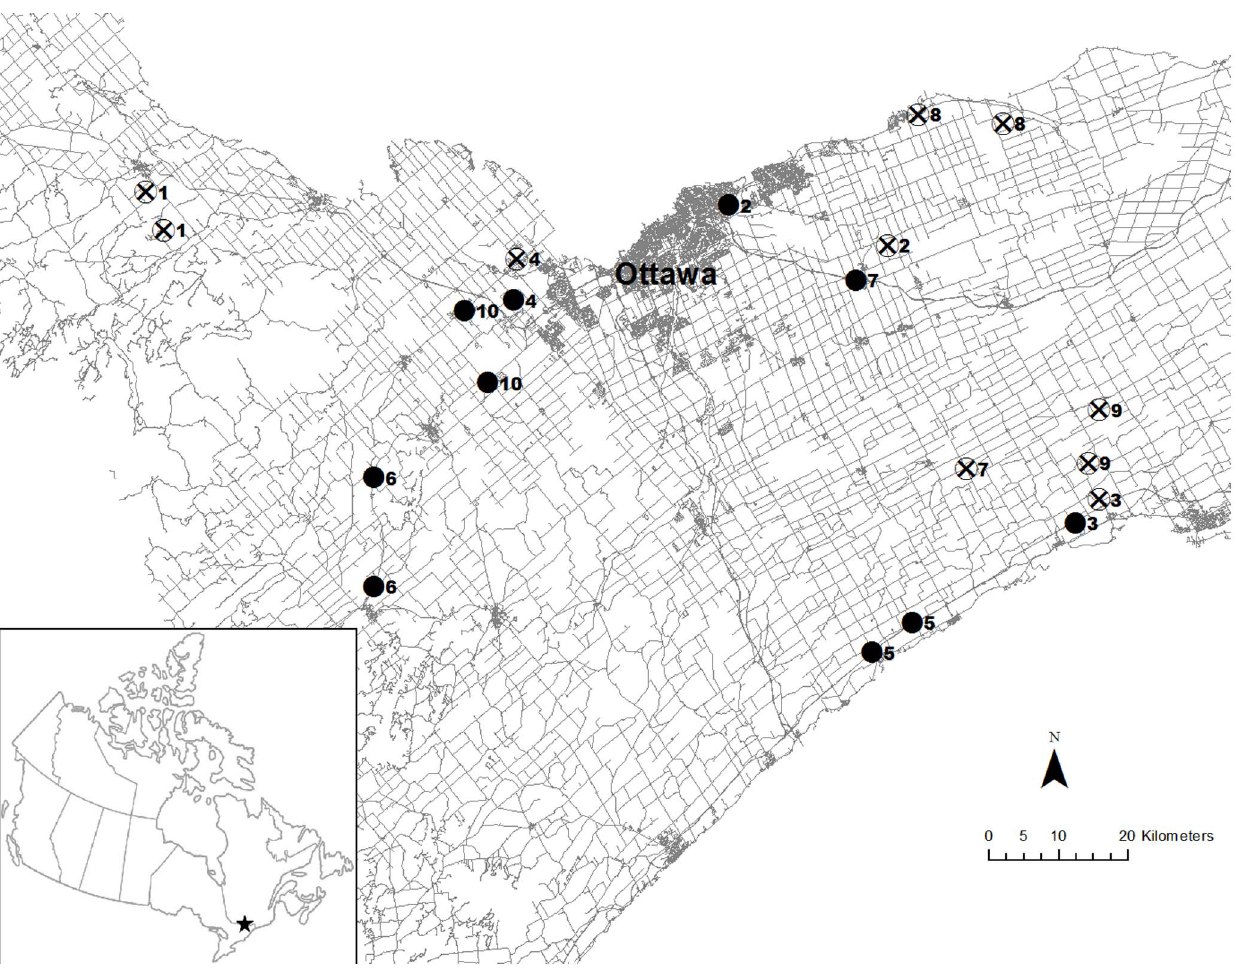
Figure 1. Sampled pond distribution across Eastern Ontario. Distribution of the 20 ponds (10 Road (solid black circles) and 10 No Road (crossed circles) sites) sampled across Eastern Ontario from 1 June to 28 August 2011. Ponds were paired for sampling based on geographical proximity. Paired sites share the same number (1–10) based on the order in which they were sampled.